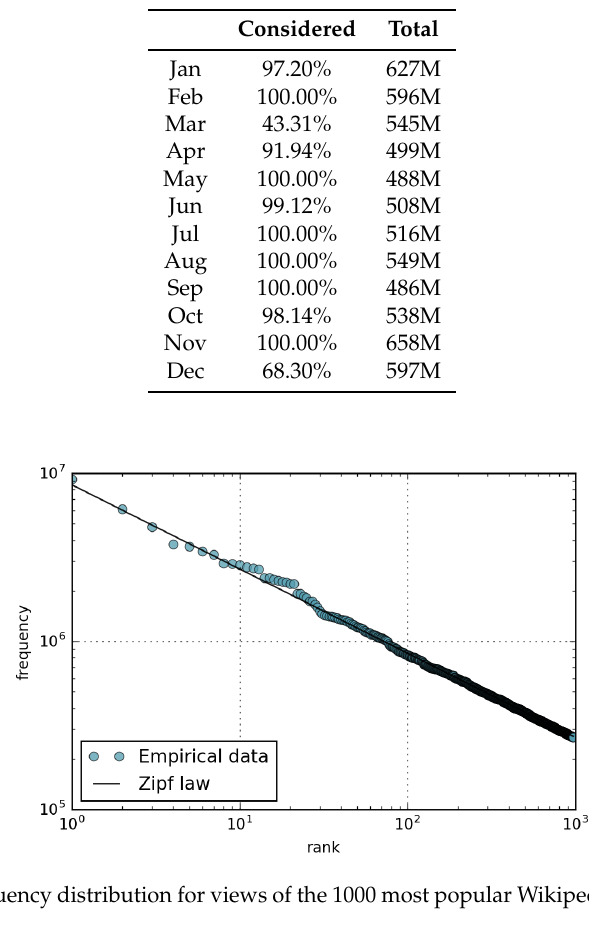
Table 1. Total and considered views for the top 1000 Wikipedia pages in 2016.